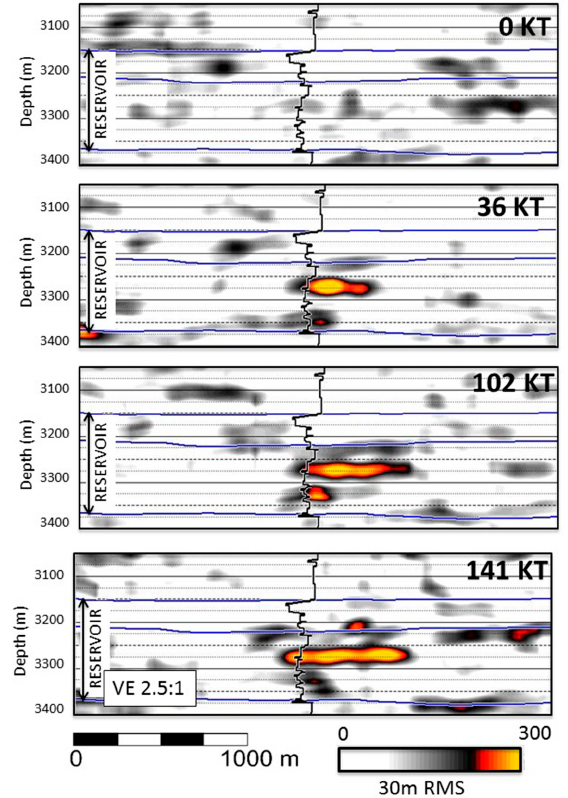
Figure 7. Time-lapse DAS-VSP imaging tracking a CO 2 plume. As the volume of injected CO 2 increases, the amplitude change relative to the baseline image increases. Figure from While et al. (2020), SEG Annual Meeting Expanded Abstracts.